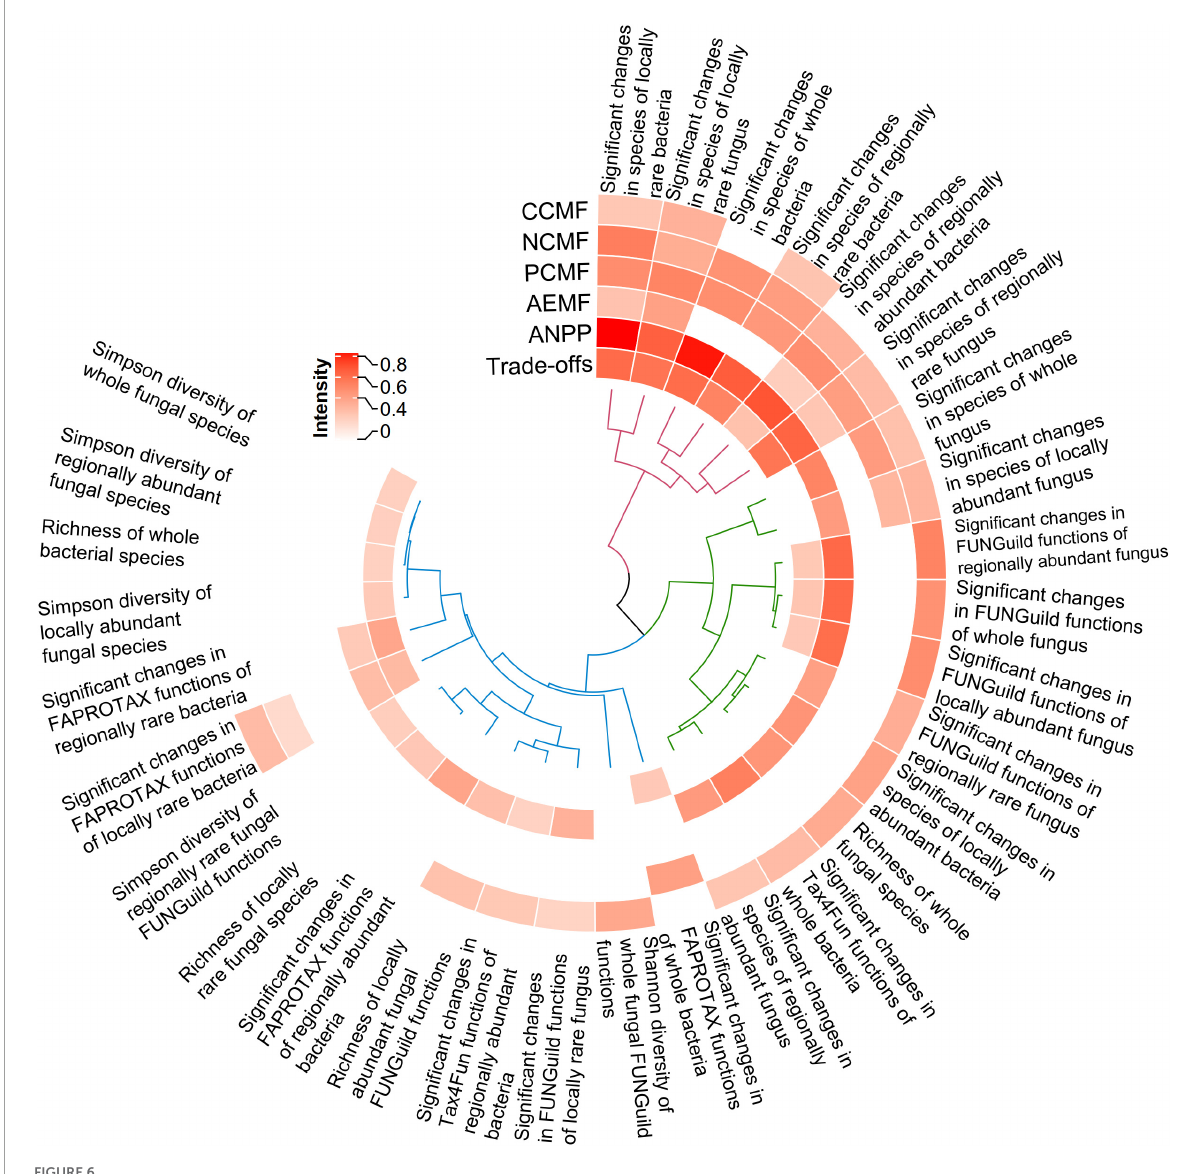
FIGURE6 Heatmap showing the intensity of the selected species (or functions) or the diversity indices impacting rhizosphere functions and aboveground net primary productivity (ANPP). The intensity was indicated by r of Mantel test. The selected species (or functions) were the intersection of species or functions that significantly differed among the groups (MZ, IZ, MS, and IS) and were significantly correlated with system function (C/N/P-circling multifunctionality, AEMF, and ANPP, respectively). Only the significant intensity was showed. Hierarchical cluster analysis showed the clusters of factors. CCMF, carbon-circling multifunctionality; NCMF, nitrogen-circling multifunctionality; PCMF, phosphorus-circling multifunctionality; AEMF, average ecosystem